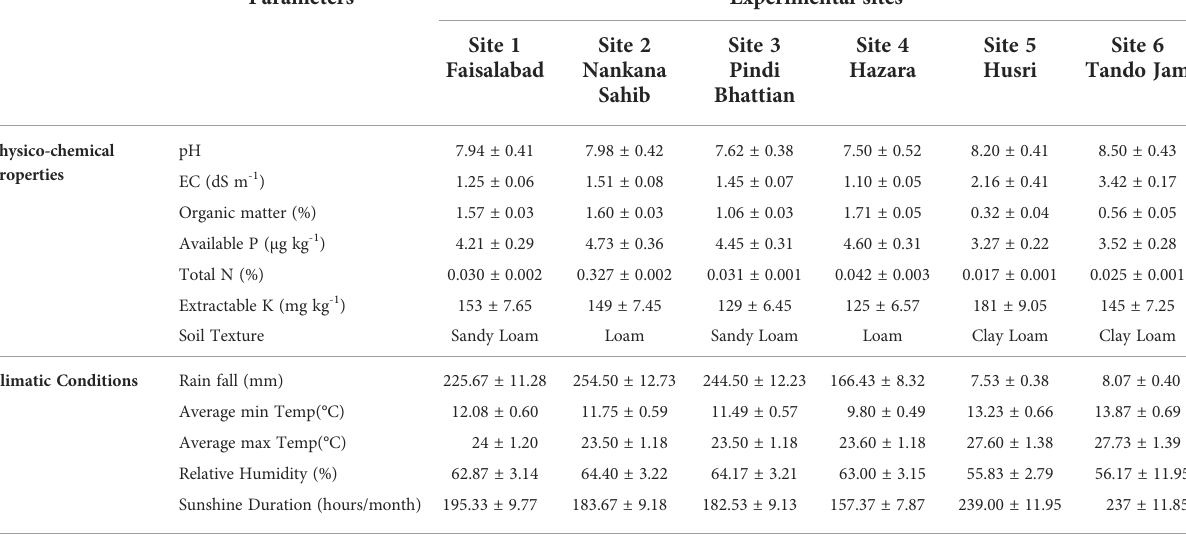
TABLE 1 Physicochemical properties of soils collected and environmental data of the experimental fi eld